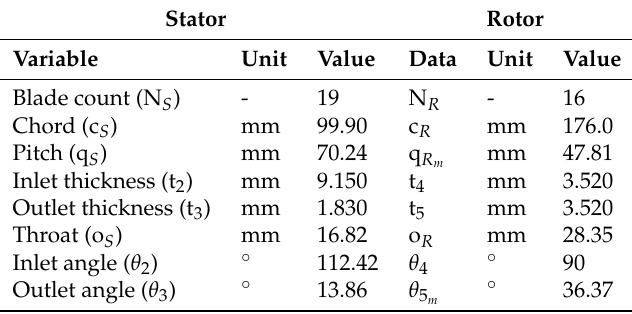
Figure 3. 3D model of selected turbine: ( a ) Front view, ( b ) Perspective view. Table 6. Geometric parameters of turbine stator ( S ) and rotor ( R )